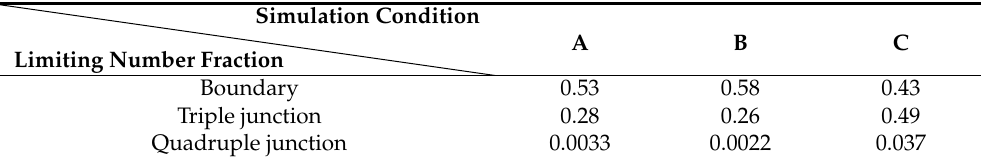
Figure 6. Simulated microstructures for r = 7.8 μm and f V = 0.08 when t = 100 and 350 s. Table 1. Limiting number fractions of particles contacting with grain boundary, triple junction and quadruple junction for different simulation conditions.